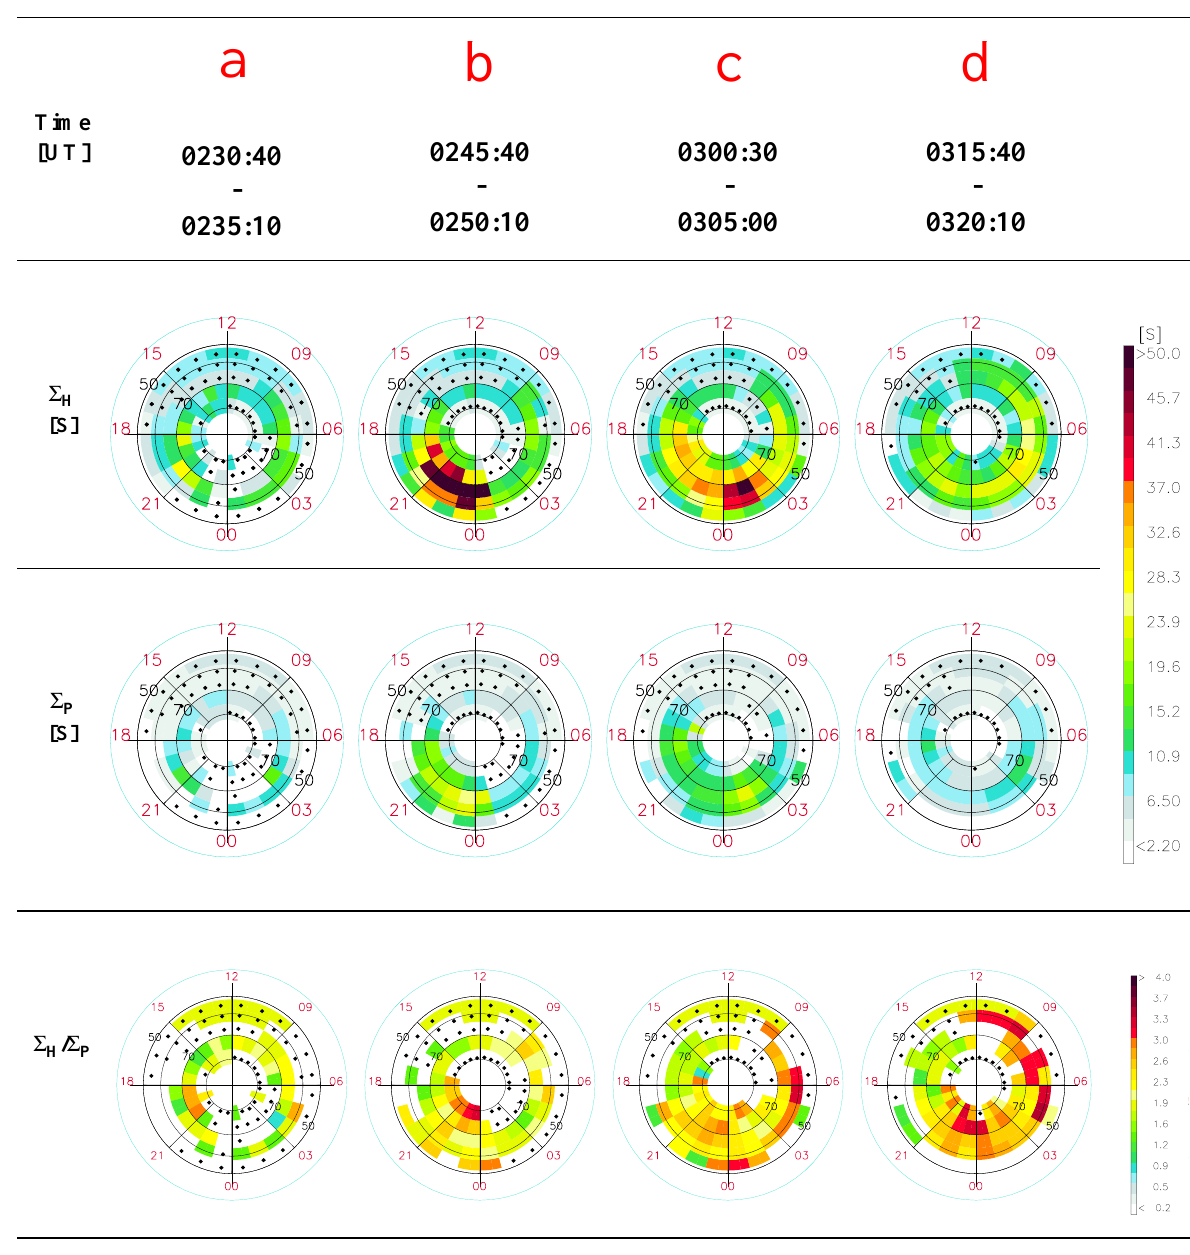
Fig. 2. Polar plots of the Hall and Pedersen conductances for 8 successive time periods during the isolated substorm event on 31 July 1997. Boxes where we have only included the contribution to the conductances from the background are marked with a black dot. Also presented are the Hall to Pedersen conductance